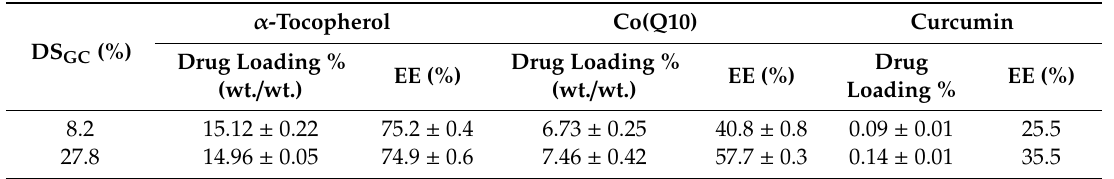
Table 2. Encapsulation of hydrophobic models in amphiphilic hyaluronan using curcumin, coenzyme Q10 (coQ10), and α -tocopherol models. Values are presented as mean ± SD; n = 3. α -Tocopherol Co(Q10) DS GC (%)